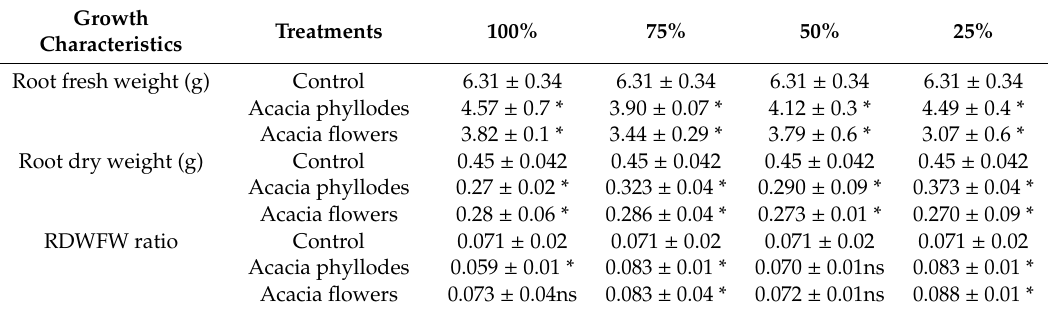
Table 4. E ff ect of aqueous extract of aerial foliage of Acacia melanoxylon R. Br. on root fresh weight (g)